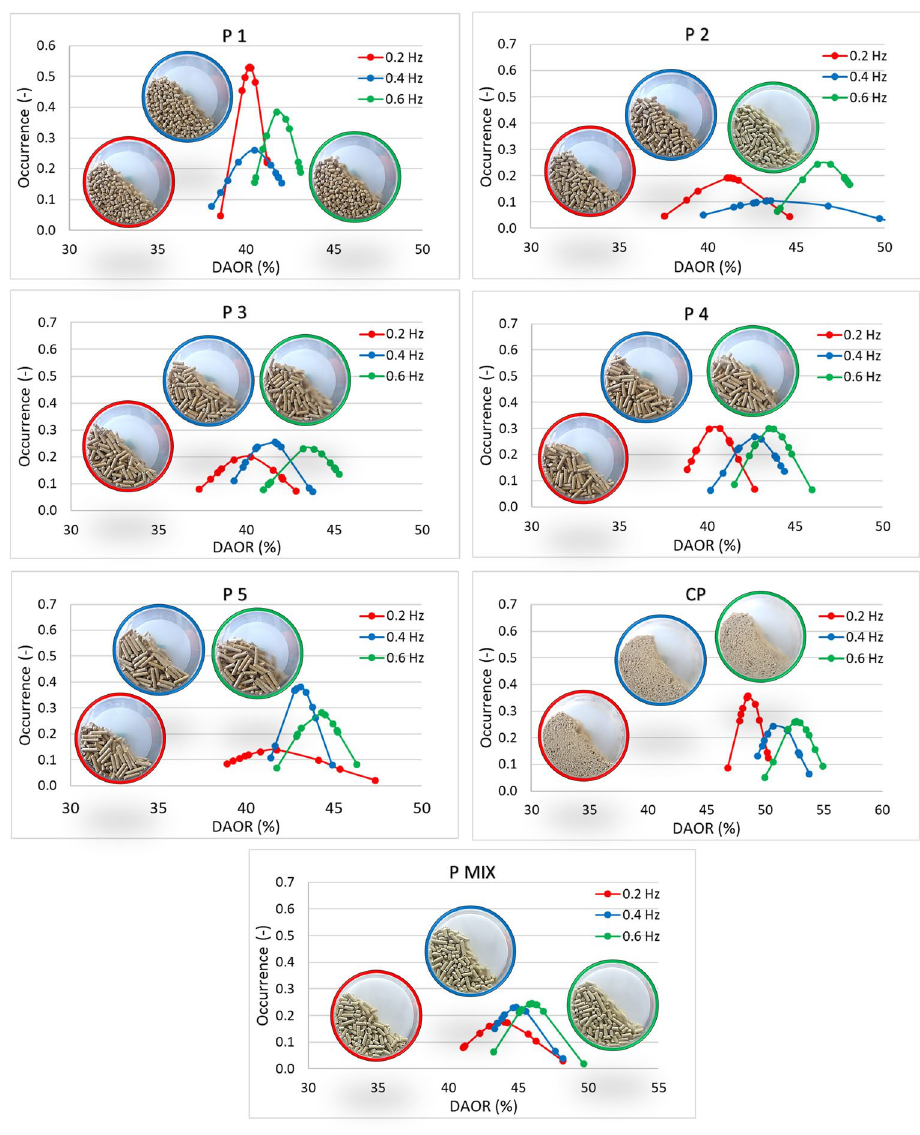
Figure 16. Dynamic angle of repose (DAOR) for pellets and